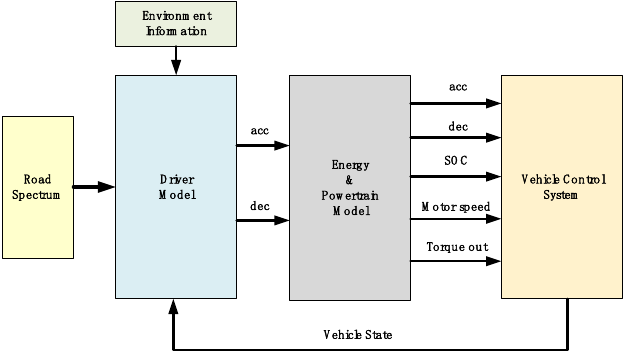
Figure 1. Vehicle model schematic (acc, acceleration signal; dec, deceleration signal; SOC, state of charge).